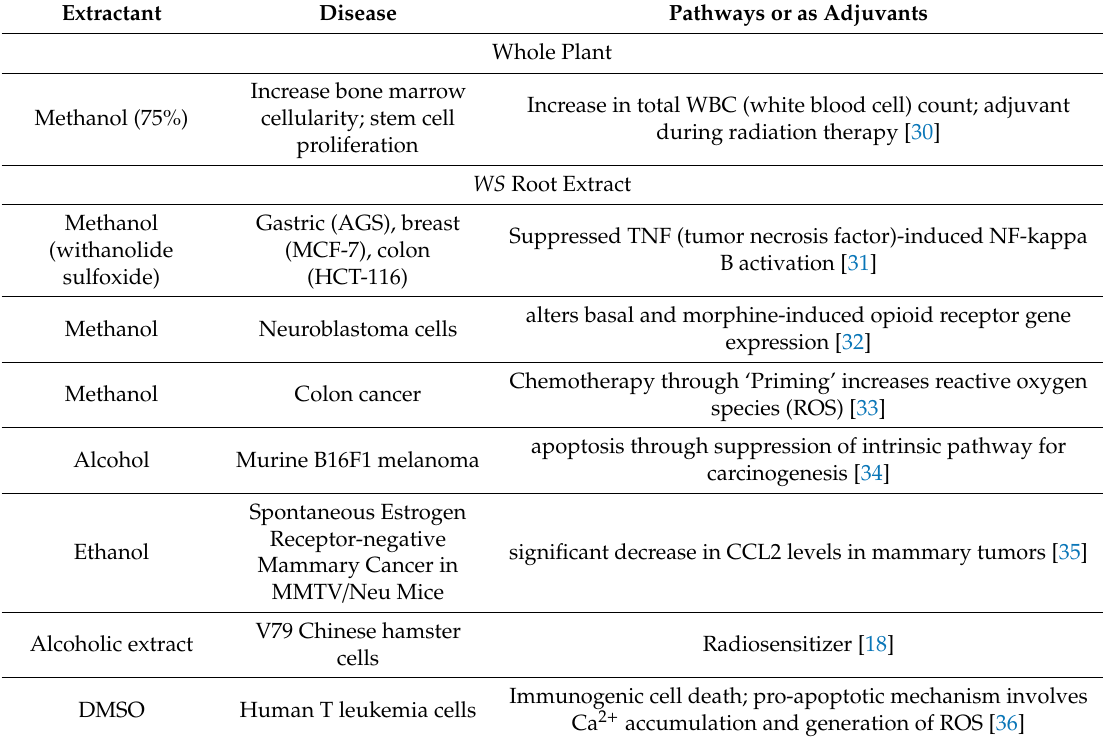
Table 2. Role of WS extracts of the di ff erent parts of the plant in cancers and the plausible pathways. Extractant